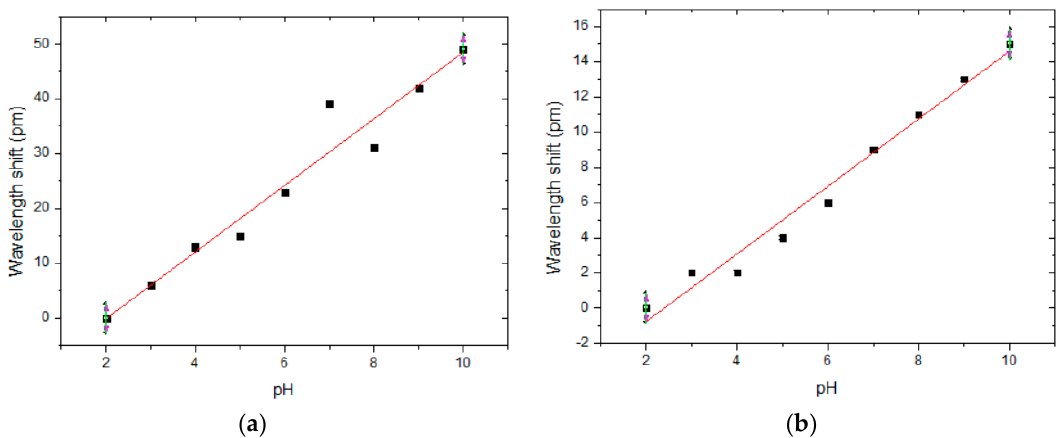
Figure 2. pH calibration curve for hydrogel coating on fibre sensors with ( a ) GO evaporated; ( b ) GO co- electroplated,